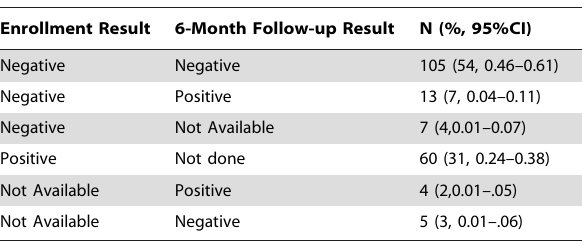
Table 5. Agreement of enrollment and 6 month follow-up results by TST–N